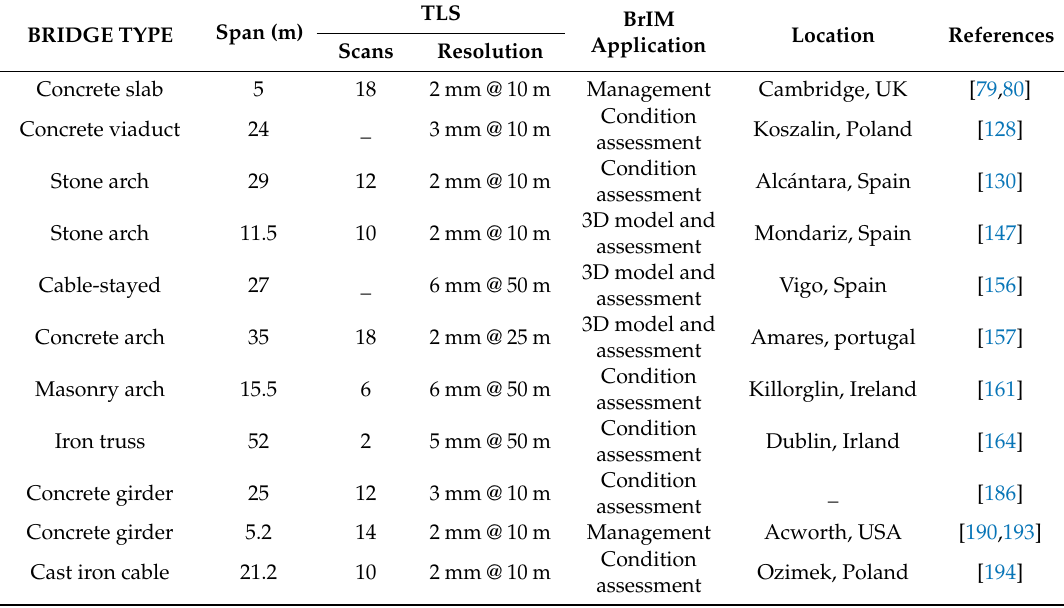
Table 9. Examples of TLS based bridge information modeling (BrIM) for di ff erent types of bridges. BRIDGE